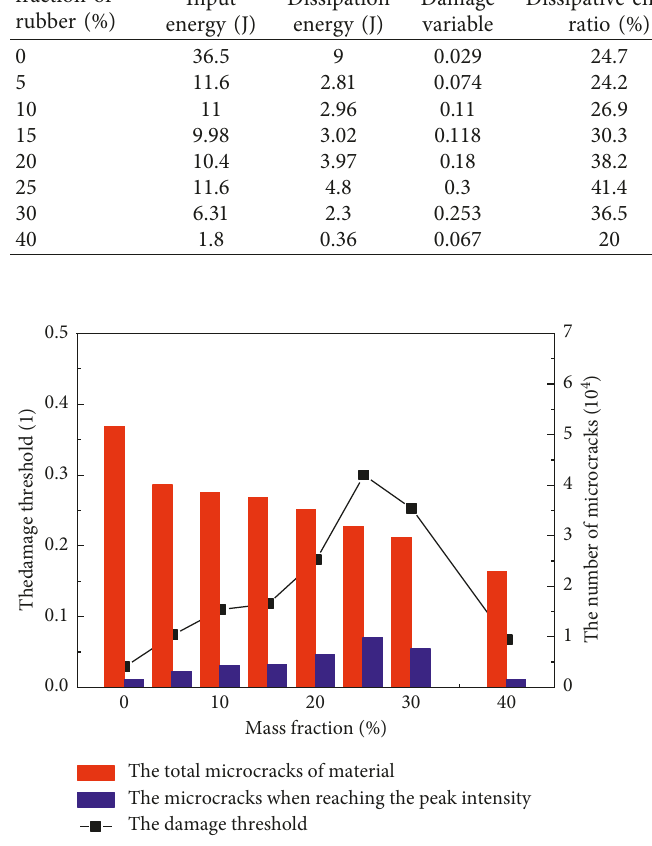
Figure 13: Relationship between damage threshold, number of microcracks, and content of rubber